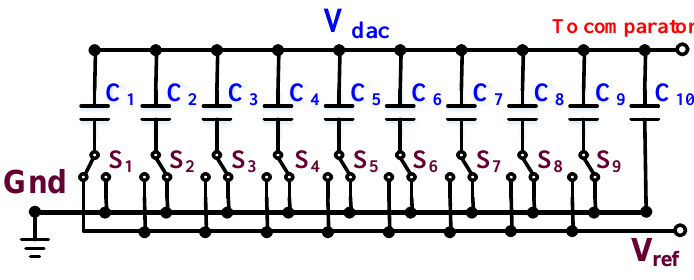
Figure 8. Proposed 10-bit binary-weighted capacitive DAC.